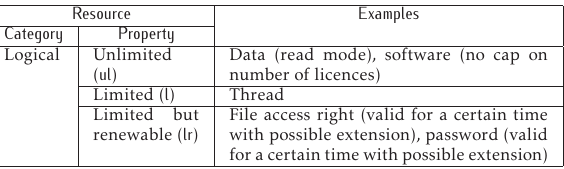
Table 3. Examples of logical resources per property type Resource Examples